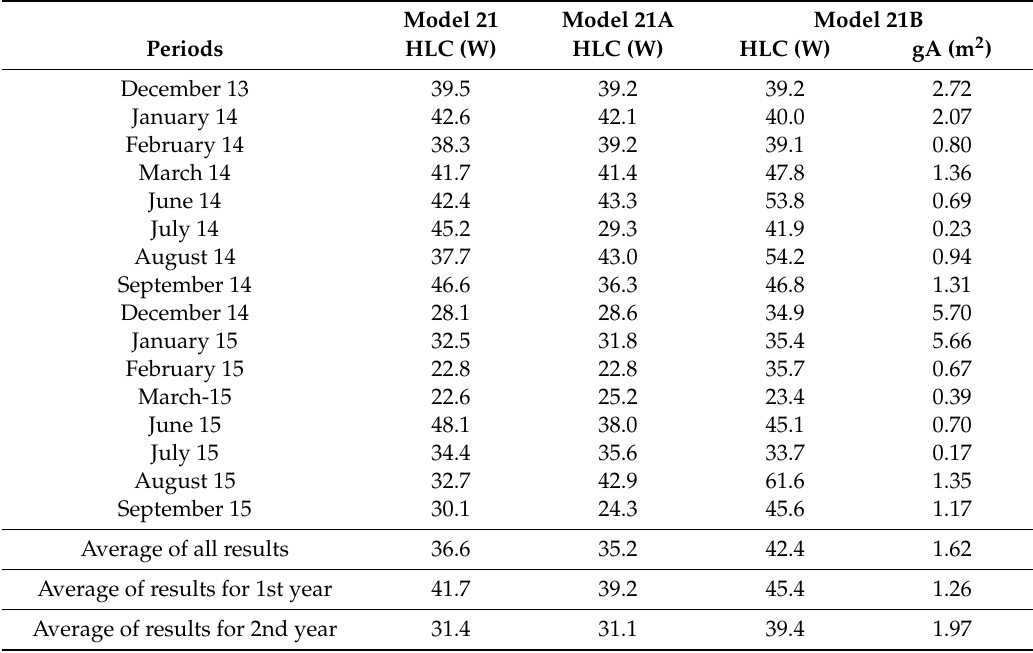
Figure 12. Results obtained using Model 21 for the data series of winter and summer in the first year. ( a ) HLC obtained using Model 21 as it is in Figure 10, ( b ) HLC obtained eliminating P PV from node 2 in Model 21, ( c ) HLC using G h instead of P PV in Model 21, ( d ) gA using G h instead of P PV in Model 21. Table 3. Results obtained using Model 21 and its variations using different models for solar gains.